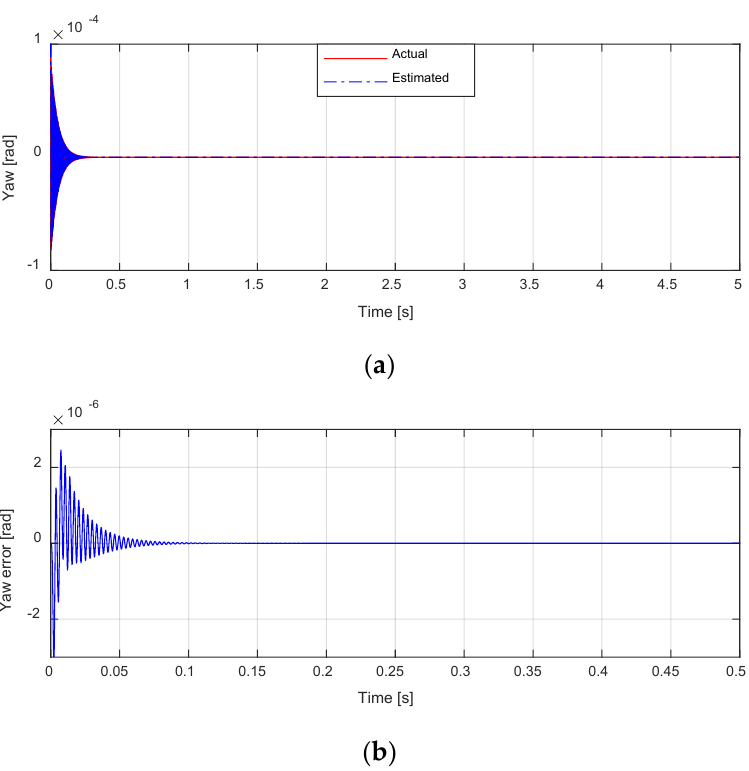
Figure 4. Estimation performance of X − axis. ( a ) Estimation performance of estimation error.